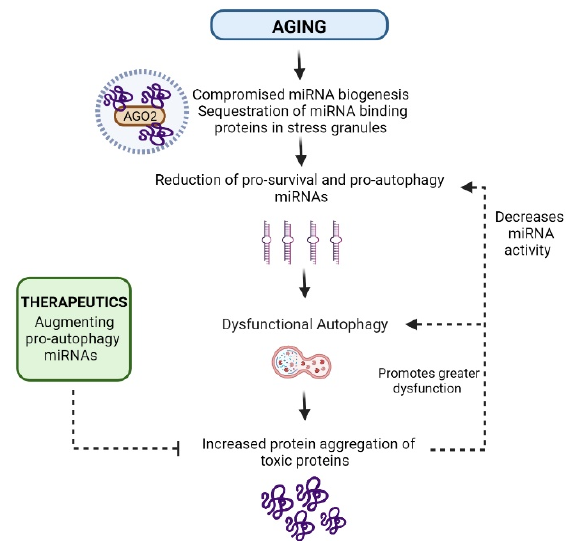
Figure 2. The interplay of aging and age-related protein aggregation in miRNA expression and proteostasis imbalance in mammalian tissues. During aging, alterations in miRNA biogenesis lead to an overall reduction or imbalance in pro-survival and pro-autophagy miRNA levels. Due to these changes, autophagic degradation becomes increasingly hindered over time, thus leading to increased accumulation of toxic proteins. With the rise of this toxic protein aggregation, autophagic clearance mechanisms become oversaturated and inefficient in degrading toxic proteins. At the same time, it is believed that the presence of toxic protein aggregation hinders miRNA activity, with miRNA binding proteins such as Argonaute-2 (AGO2) and AGO2–miRNA complexes being sequestered in stress granules and hindering their modulation of protein degradation target genes such as autophagy-associated genes. One effective intervention strategy involves augmenting the levels of pro-autophagy miRNAs in order to deal with the accumulation of toxic protein aggregates over time.